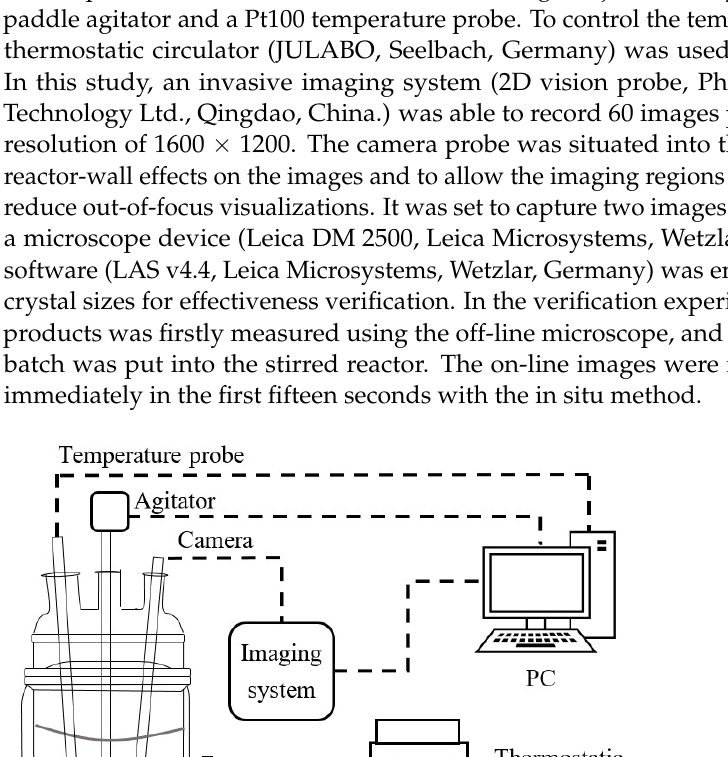
( b ) Figure 1. The crystal morphology of α-form LGA: ( a ) crystal image of α-form LGA; ( b ) schematic representation of α-form LGA. 2.2. Experimental Setup Experiments were carried out with a 2 L glass jacketed crystallizer, a PTFE four-pad-